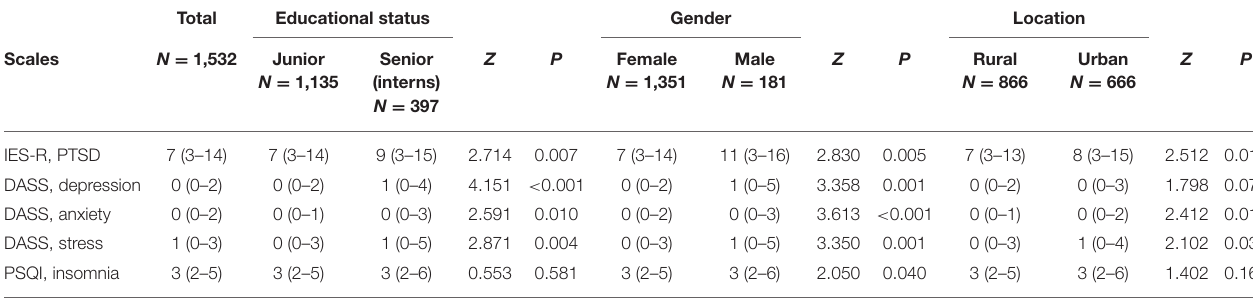
TABLE 2 | Scores of PTSD, depression, anxiety, stress, and insomnia.